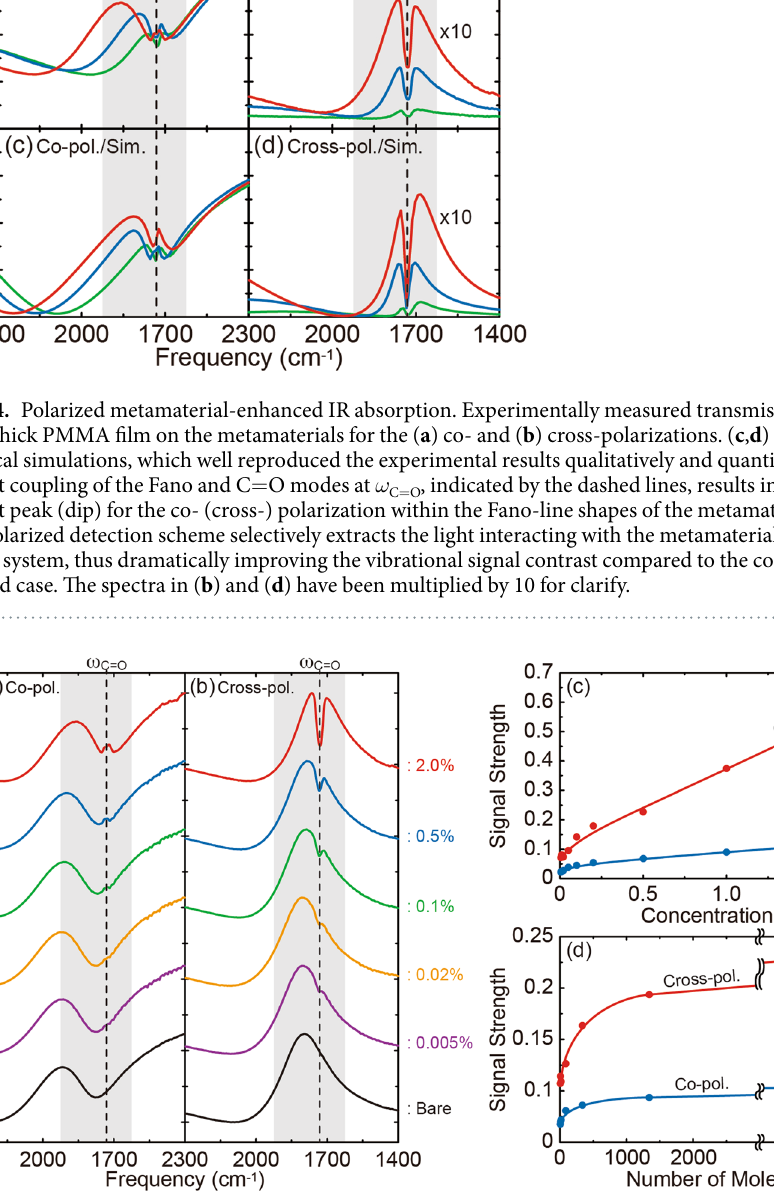
To quantitatively evaluate the ultimate sensing capability of the cross-polarized SEIRA, the vibrational sig- nal strengths for the co- and cross-polarizations were experimentally measured by progressively decreasing the solid content of PMMA solution. Figure 5(a) and (b) show the measured co- and cross-polarized transmission spectra of the PMMA-coated FRAMs h / s = 0.75 (red) for different PMMA concentrations from 2.0 to 0.005% in an anisole solvent. For better illustration to evaluate the sensitivity, the concentration dependences of the extracted signal strengths are shown in Fig. 5(c). Here, the signal strength is defined as the spectrum differ- ence between the PMMA-coated and bare FRAMs, considering the red-shift effect due to the non-dispersive refractive index of a PMMA film 32 . By taking into account the dependence of the final film thickness on the concentration and on the spin speed 39 , Fig. 5(c) can be replotted in Fig. 5(d) as the function of the number of PMMA molecules within the unit cell. When the number of molecules decreases, the signal strengths for